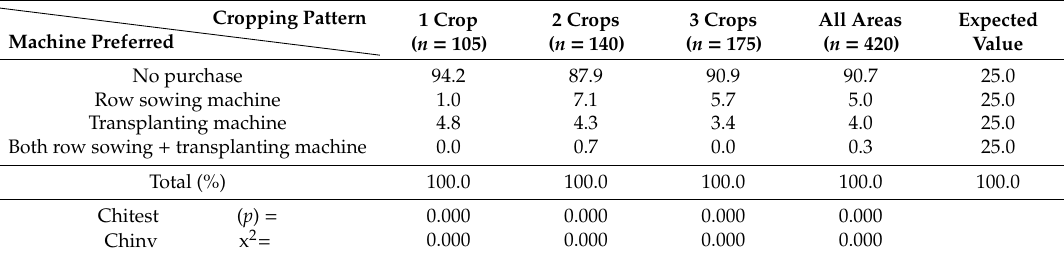
Table 10. Rate of respondents who wanted to purchase transplanting machine (%). Machine Preferred